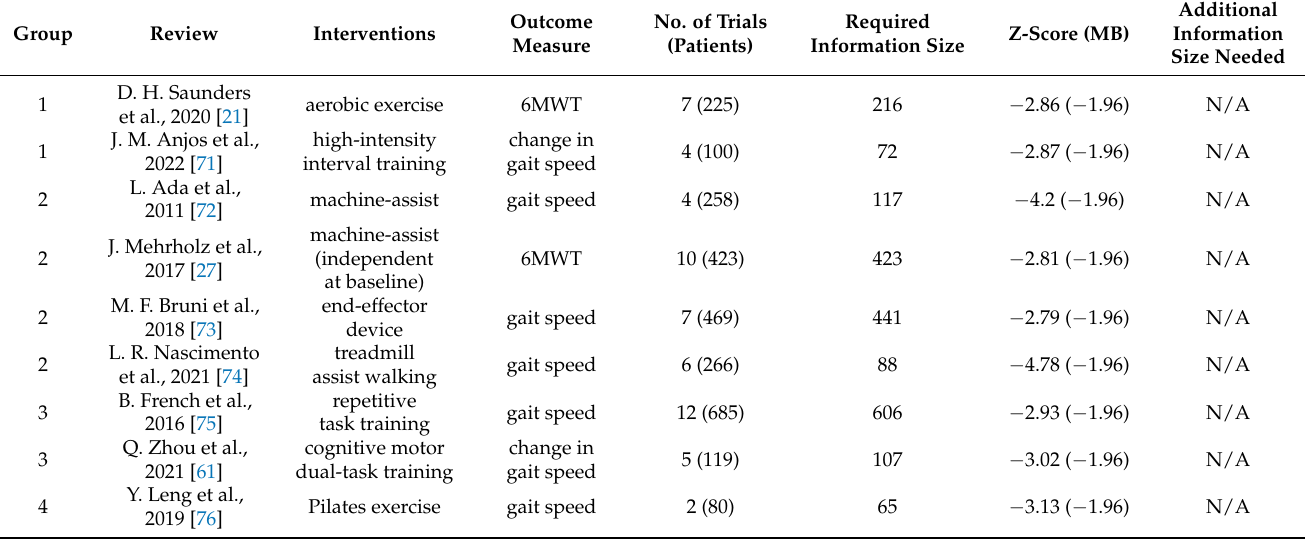
Table 8. Studies with verified intervention effects on gait speed.